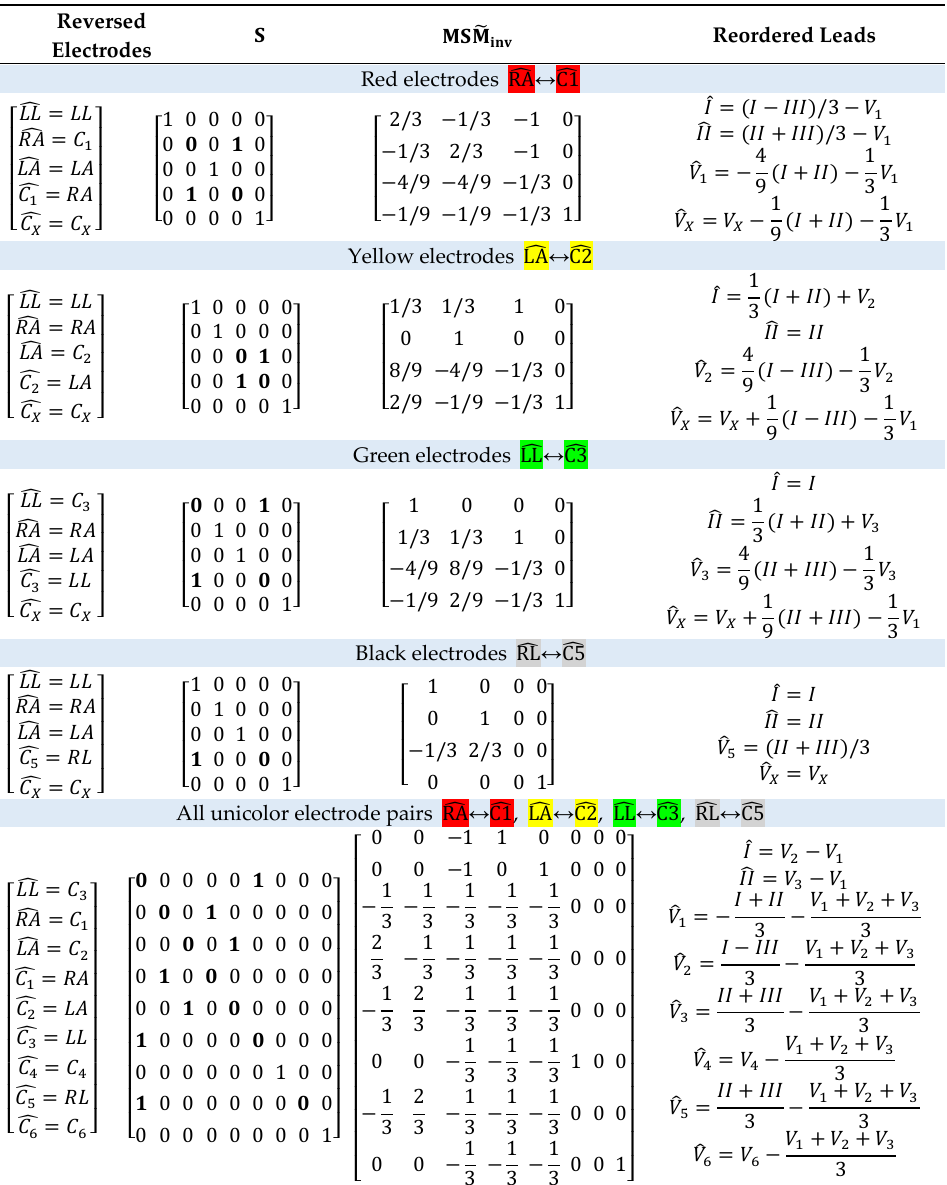
Table 4. Reversals of unicolor chest and peripheral electrodes.